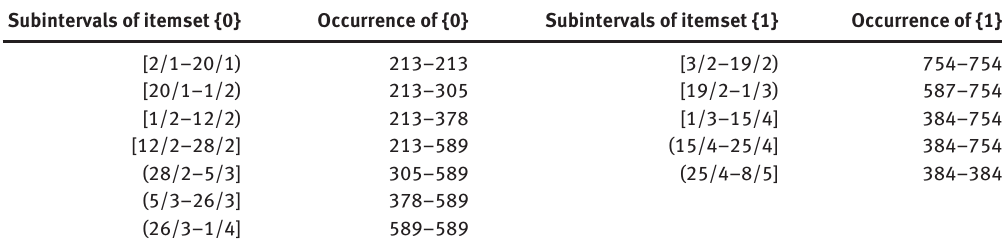
Table 7. Subintervals of Yearly Periodic Itemsets Along with Quantity (for retail